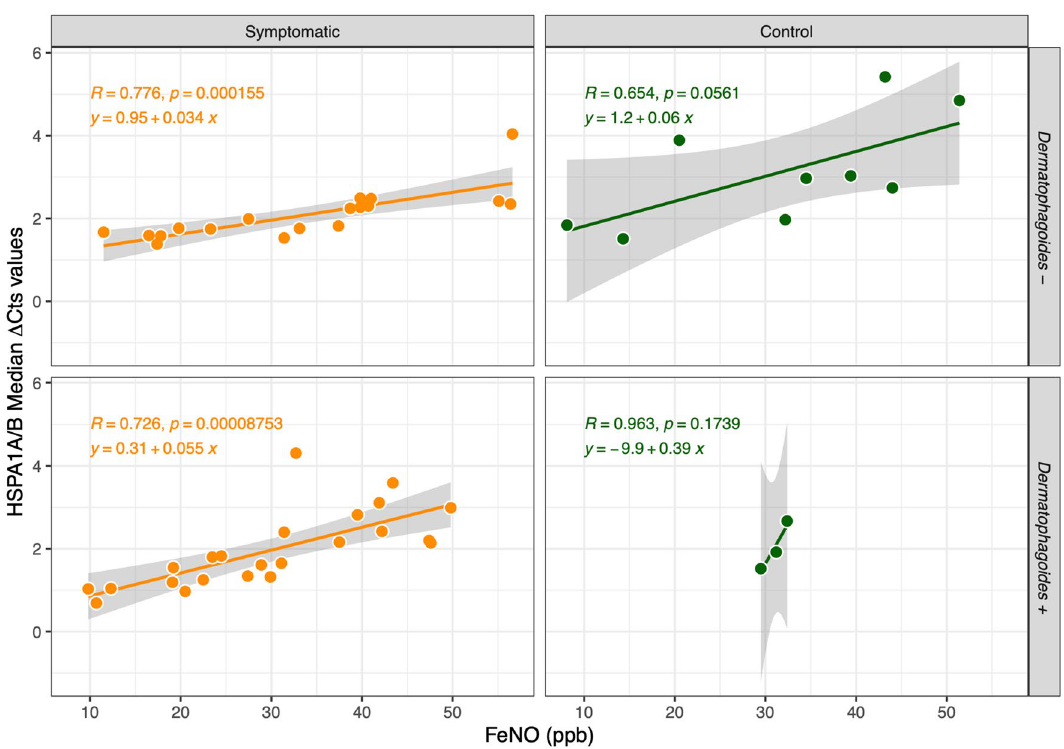
Figure 4. Regression and correlation between FeNO concentration and ∆Cts of HSPA1A/B in AR symptomatic subjects and control group, separated by Dermatophagoides allergens